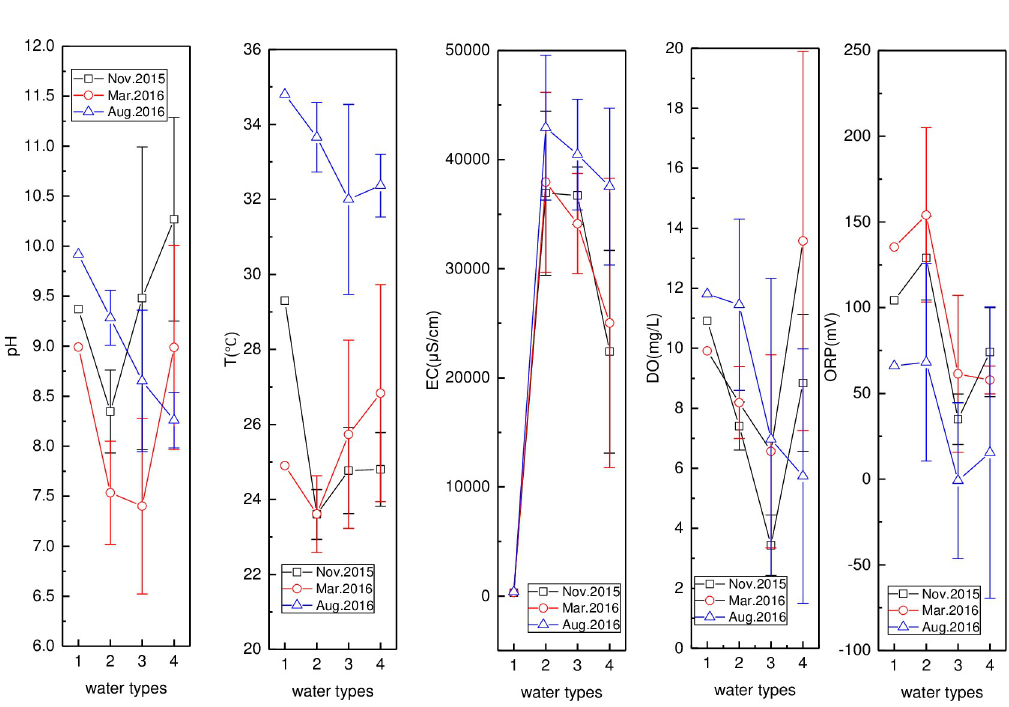
Fig 7. Nitrogen, phosphorus, Chl . a , and COD in the reservoir, Bamen Bay, mangrove, and aquaculture (these water types are represented by 1–4).